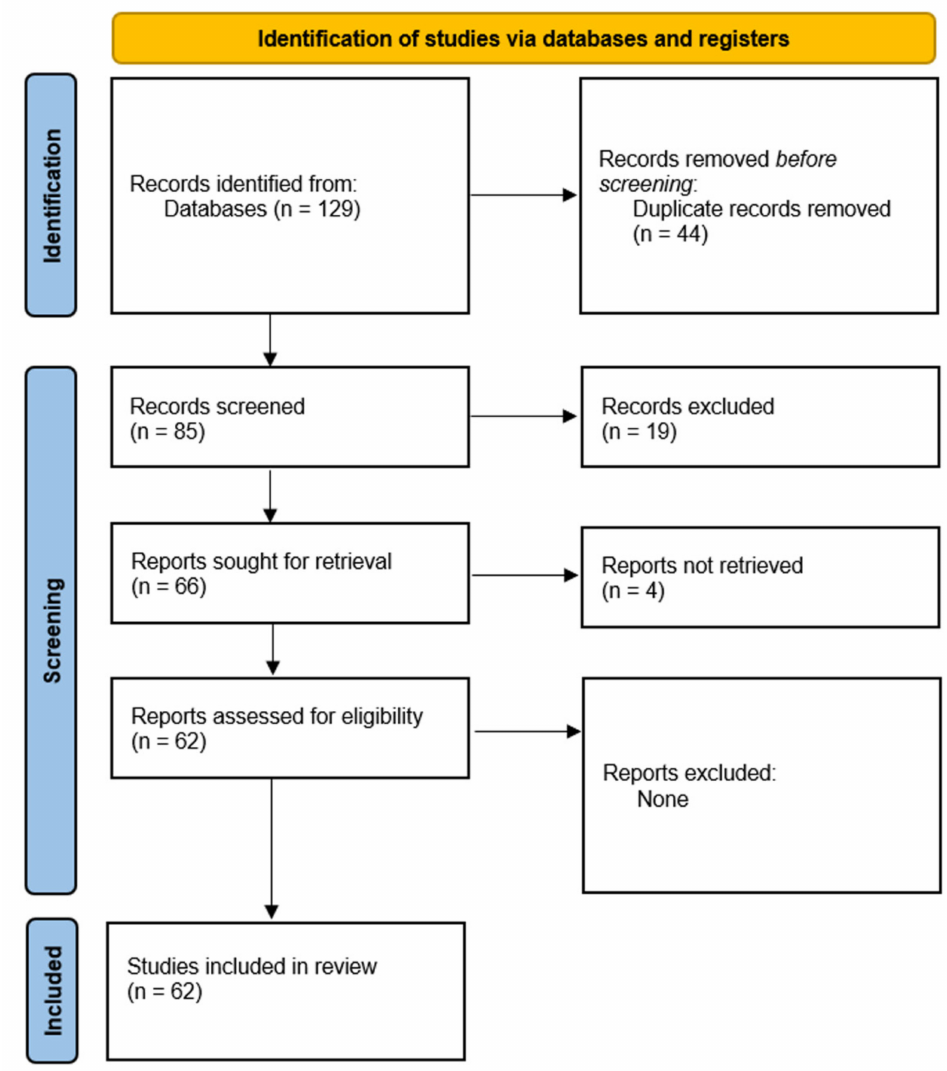
Figure 1. PRISMA flow diagram for the systematic